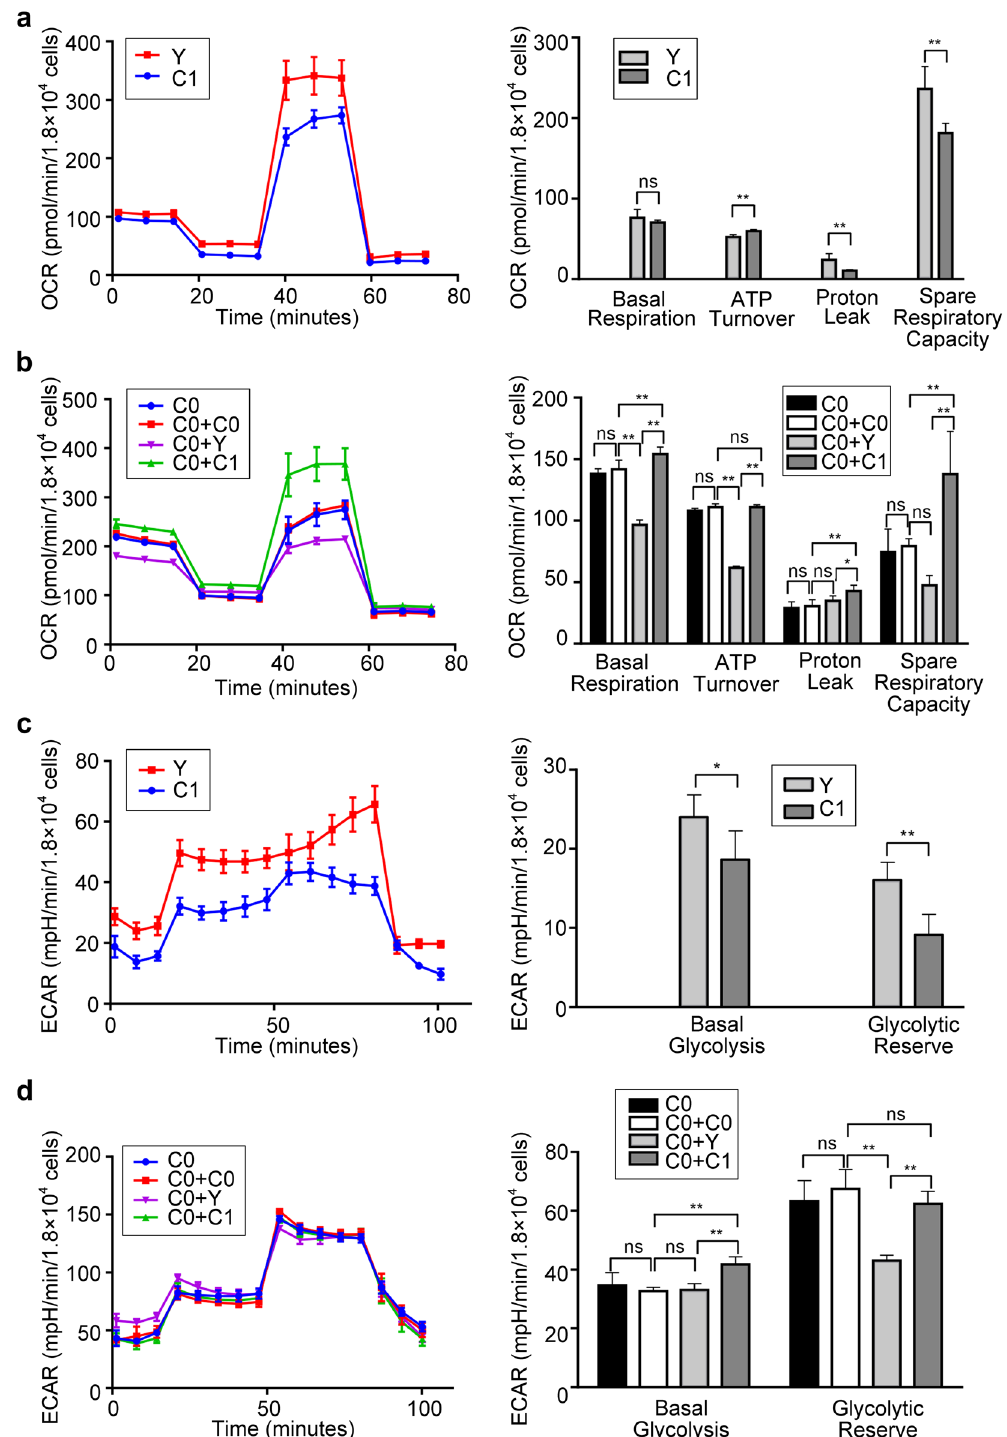
Figure 2. OCR and ECAR assays for bovine primary cells and cybrid cells. a and c illustrating OCR and ECAR assays of primary cell lines (Y and C1). b and d illustrating OCR and ECAR assays of cybrid cells (C0 + C0, C0 + C1, C0 + Y), C0 (MAC-T) was used as a control for C0 + C0. For OCR assays, all cells exposed sequentially to oligomycin, FCCP and rotenone plus antimycin A. Non-mitochondrial respiration was subtracted from the other values, basal respiration, ATP turnover, proton leak, and spare respiratory capacity. OCR profiles were expressed as pmole O2/min/1.8 × 10 4 cells. The basal glycolysis rate for each cell line was estimated by determining its ECAR in the presence of glucose. The glycolytic reserve for each cell line was estimated by determining the ECAR in the presence of oligomycin. ECAR profiles were expressed as mpH/min/1.8 × 10 4 cells. In cybrid cells, the acronym C0 denotes a common nucleus of MAC-T, and + C0, + Y and + C1 represent the source of mitochondria. Bars indicate the standard deviation (SD), n = 6 per group. * P < 0.05, ** P < 0.01 and ns P >